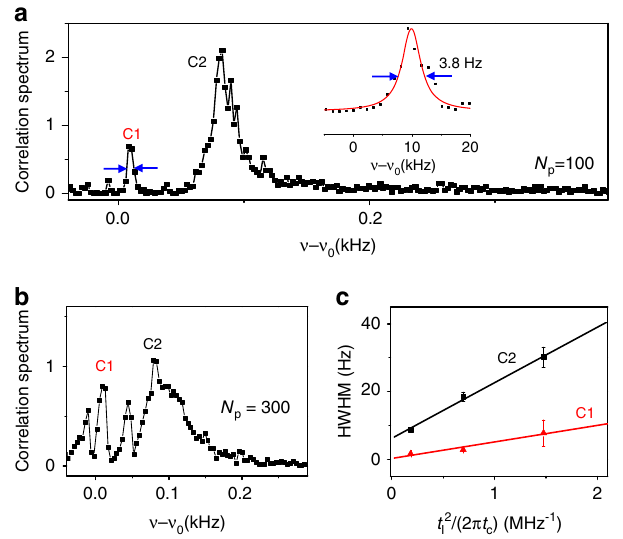
Fig. 4 High-resolution spectroscopy of single nuclear spins. a , b Correlation spectra of sequential measurements of single nuclear spins weakly coupled ¼ 100 and 300, to the sensor NV2, for the KDD pulse number N p respectively. The two peaks C1 and C2 are ascribed to two different nuclear spins. The inset in ( a ) is a close-up of the peak C1, with a Lorentzian fi t (red line). c The half width at half maximum (HWHM) of the C1 (red triangles) and C2 (black squares) resonances as functions of the interaction time squared (which is proportional to the measurement strength). The symbols are experimental data for N P = 100, 200 and 300, and the curves represent the fi tted theory. The linear dependence indicates the broadening is caused mainly by measurement-induced dephasing. The error bars were calculated as explained in Supplementary Note 5. Source data are provided as a Source Data fi